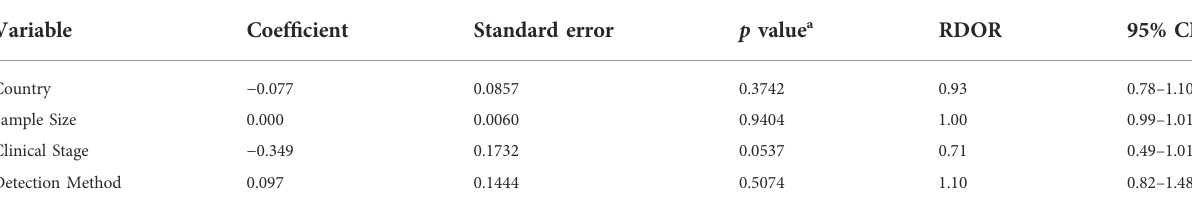
TABLE 2 Resuts of meta-regression